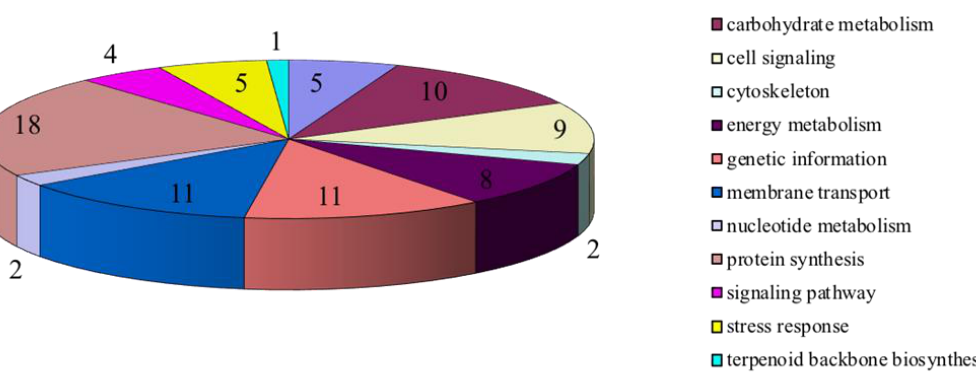
Figure 6. Pathway analysis of protein identified by 2D − DIGE gel separations from the STY geo- graphic population and HDZ geographic population of Sitobion miscanthi . From the variation in 86 proteins, only 14 proteins were upregulated for the inefficient vector against 63 proteins upregulated for the efficient